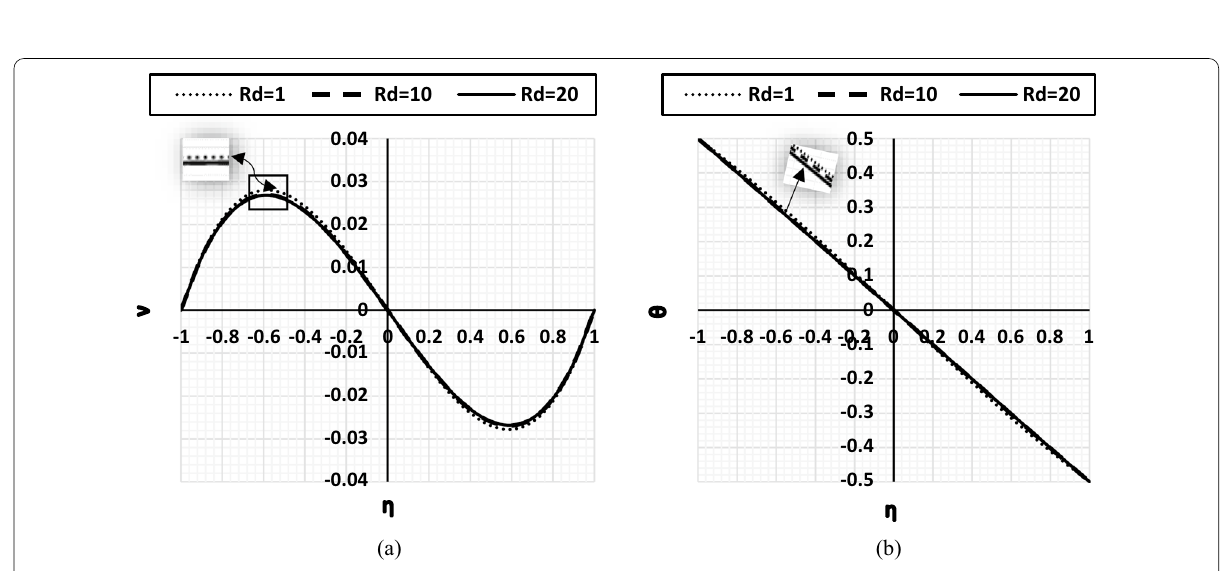
Fig. 7 Result of V (η) and θ ( η ) for various R d when ϕ